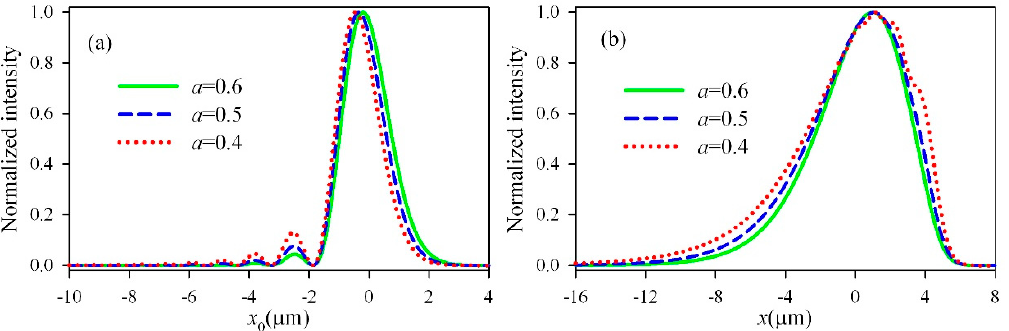
Figure 8. Normalized intensity in the x -direction of the cosh-Airy beam in the source plane z = 0 ( a ) and the observation plane z = 5 z 0 ( b ).